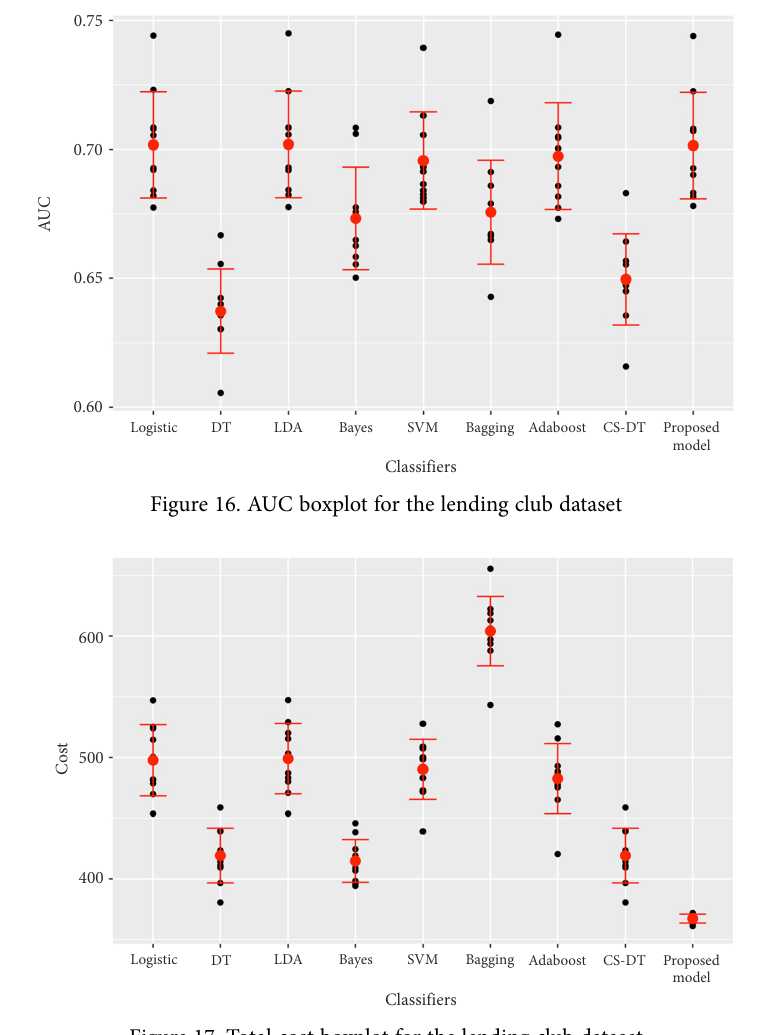
Figure 17. Total cost boxplot for the lending club